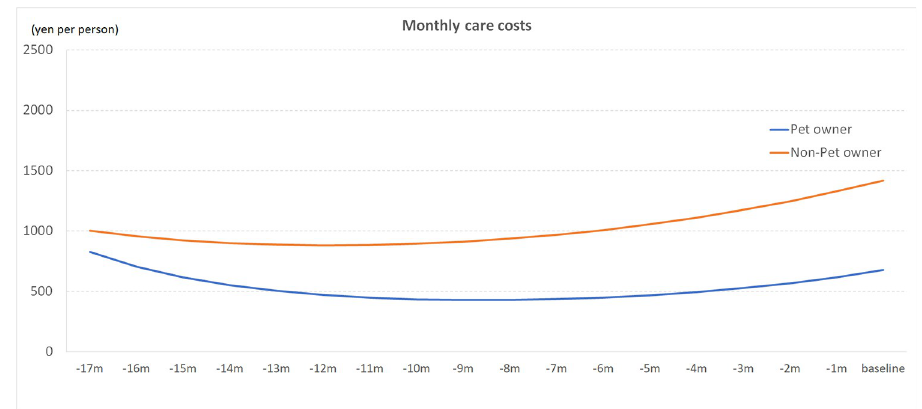
Fig 2. Trajectories of monthly long-term care costs by pet ownership